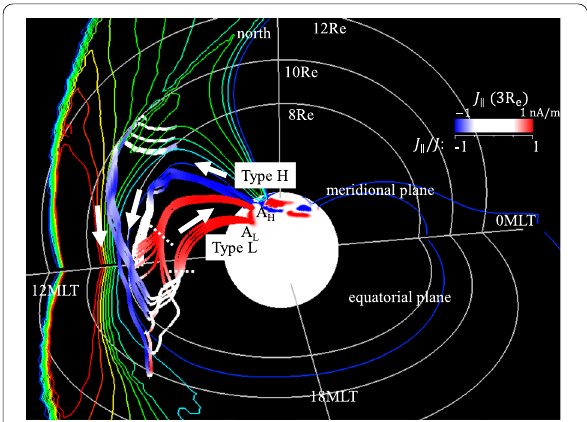
Fig. 3 Snapshots of the electric current systems at t 5.5 min as = seen from the post-noon point in the northern hemisphere. The color of the electric current lines denotes J � / | J | (blue: antiparallel, white: perpendicular, red: parallel to the magnetic field). The red and blue shadings in the lower boundary (the sphere of r = 3R e ) indicate downward and upward FACs, respectively. A H and A L indicate the projection of both areas in the ionosphere (Fig. 2) to the lower boundary. The white arrows represent the directions of the currents. The white dotted lines indicate the demarcation between the inner magnetosphere and the outer magnetosphere. The pressure in the equatorial plane and that in the noon–midnight meridian are shown with color contour lines. The type H current system from A H consists of two FACs on the pre-noon sector and the post-noon sector and the FPC connecting these two FACs. The type L current system from A L is made up of the downward FAC and the electric current in the magnetosheath via the FPC across the magnetopause. Some current lines from A L belong to the type L current